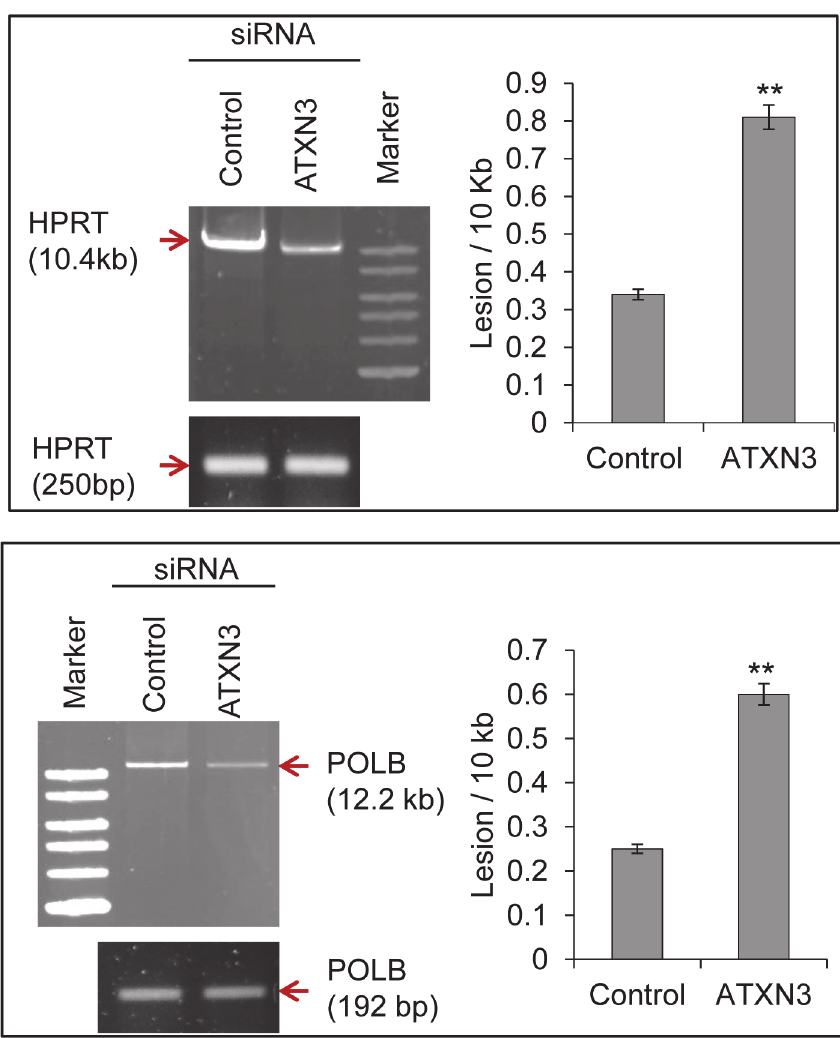
Figure 5. ATXN3 depletion increases DNA strand break levels in the nuclear genome. Long amplicon qPCR (LA-QPCR) was used to evaluate genomic DNA SB levels in control vs. ATXN3-depleted HEK-293 cells. Representative gel showing PCR-amplified fragments of the HPRT (left panel) and POLB (right panel) genes. Amplification of each large fragment (upper panels) was normalized to that of a small fragment of the corresponding gene (bottom panels) and the data were expressed as lesion frequency/10 Kb DNA as described previously [34]. Histograms represent the DNA damage quantitation for control vs ATXN3-depleted cells (n = 3, ** = P < 0.01). Error bars indicate standard error of